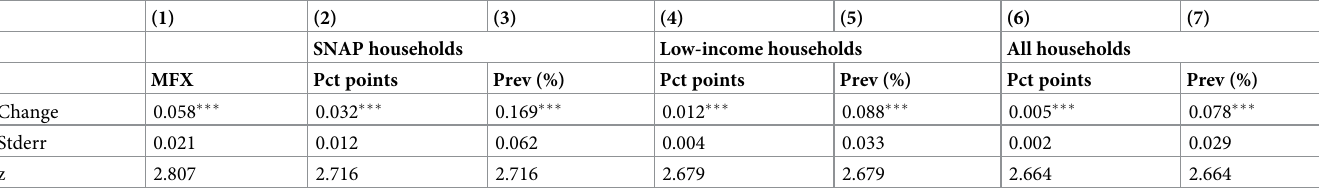
Table 6. Bootstrap estimates of under-estimate in very low food security prevalence.